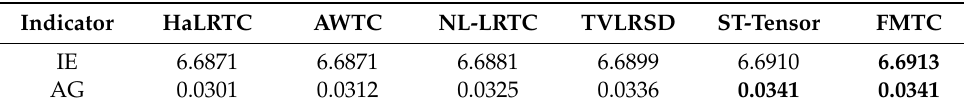
Figure 20. Enhanced detail from Figure 19a–h: ( a ) original image; ( b ) masked image; ( c – h ) recon- structed images with HaLRTC, AWTC, NL-LRTC, TVLRSD, ST-Tensor and FMTC algorithms, re- spectively. Table 7. Quantitative comparisons of six algorithms applied to dataset 7. Table 7. Quantitative comparisons of six algorithms applied to dataset 7.